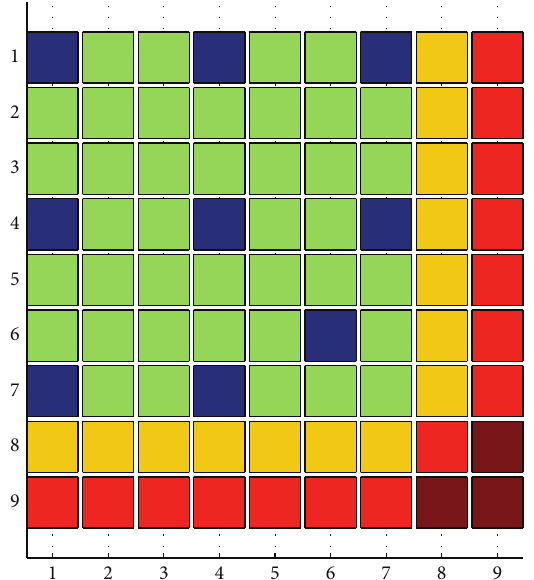
Figure 2: Lower right quarter of the 17×17 Th-MOX fuel assembly. The dark red color, light red color, yellow color, and green color represent the fuel rods that have 2.3%, 4.6%, 6.8%, and 10.2% plutonium, respectively. The dark blue color represents the guide tubes.